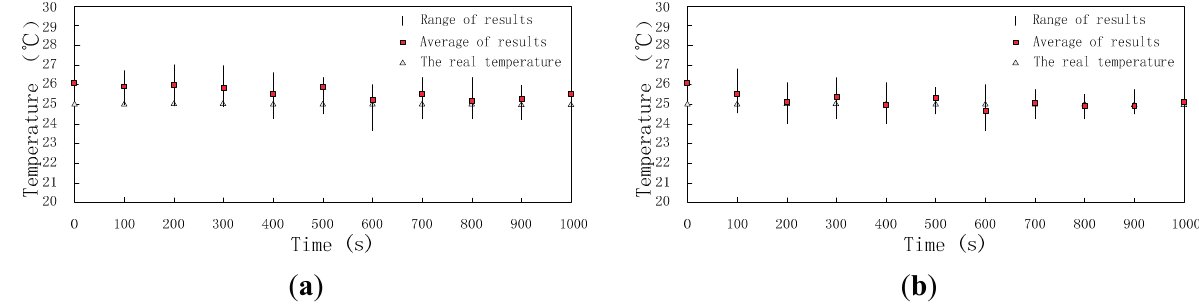
Figure 12. Data fusion results of temperature versus time. ( a ) Without DCHM; ( b ) Using DCHM.